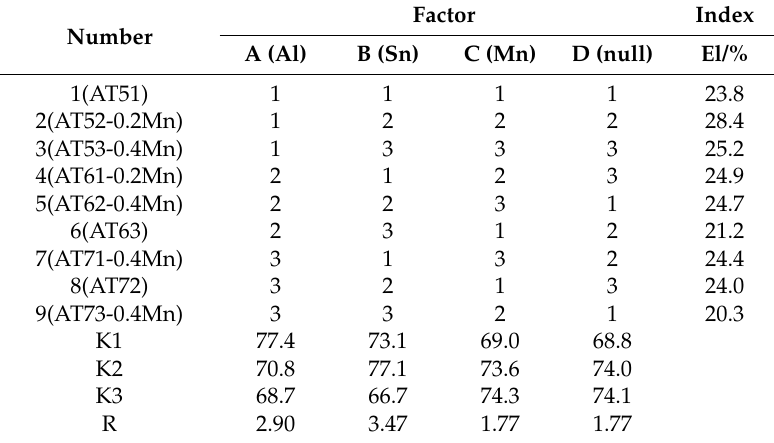
Table 6. Orthogonal test parameters and results analysis table under the elongation (EL) index.